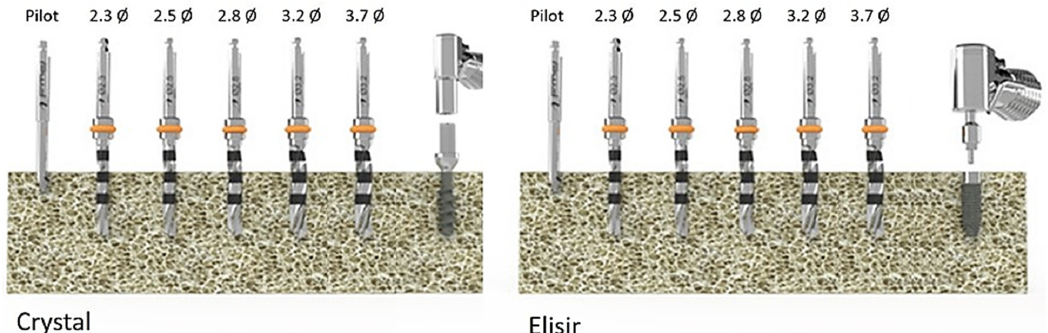
Figure 2. Drilling sequence protocol for the Elisir and Crystal Implant 3.8 mm Ø positioning. For both 4.8 mm Ø implants, one more drill with a 4.2 mm drill was performed.